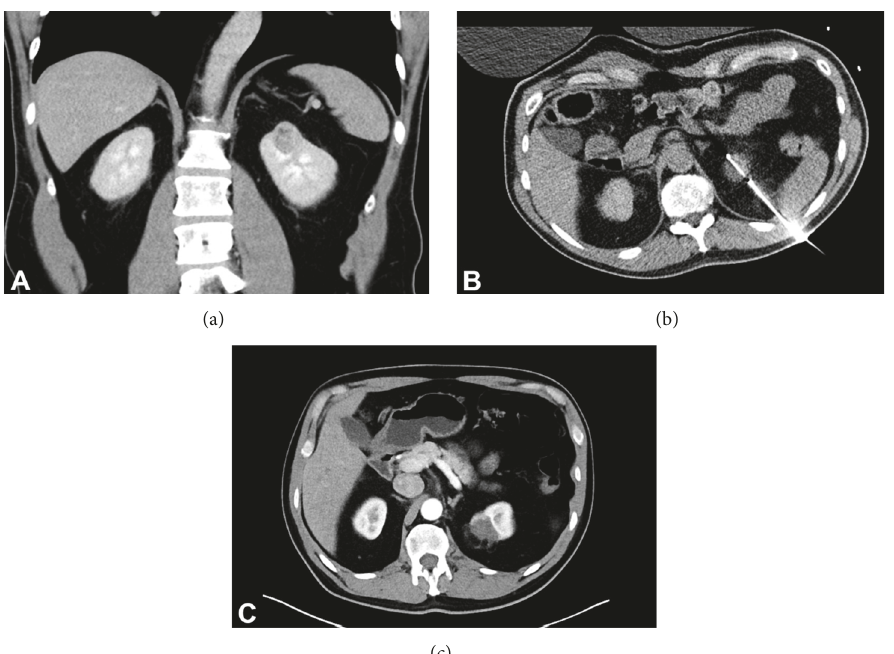
Figure 1: Patient imaging. (a) Contrast enhanced CT scan prior to ablation displaying 2-centimeter left renal mass in the upper pole. (b) An intra-therapy image of CT-guided left renal cryoablation probe displaying the tract of needle. (c) Contrast enhanced CT 1 year following cryoablation of left renal mass demonstrating absence of mass enhancement.